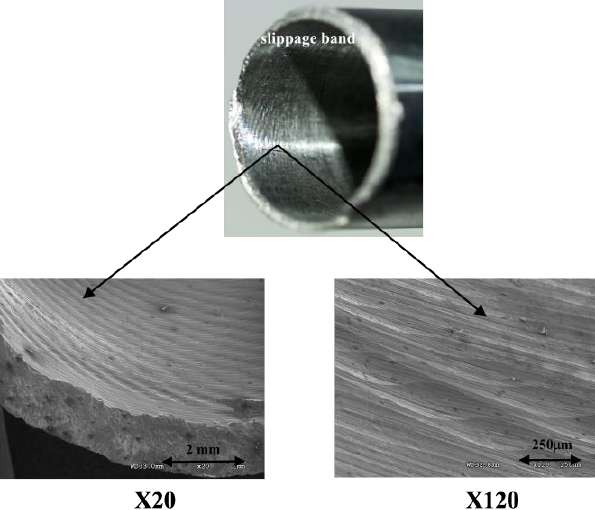
Figure 7. Slip bands (parallel faults) observed on the inner surface of a damaged tube sample (RS0—100 °C).